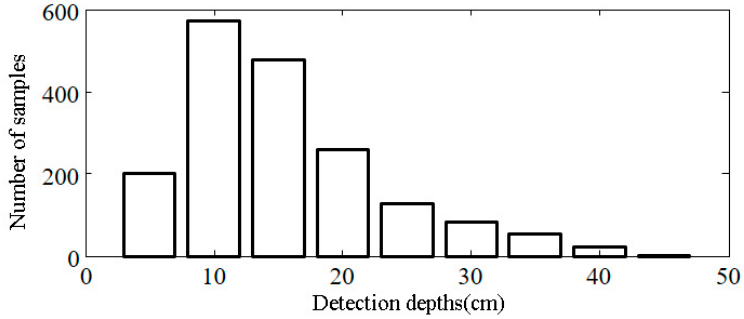
Figure 12. Soil moisture detection depths histogram generated from an aviation experiment with GNSS-R in Zhengzhou.